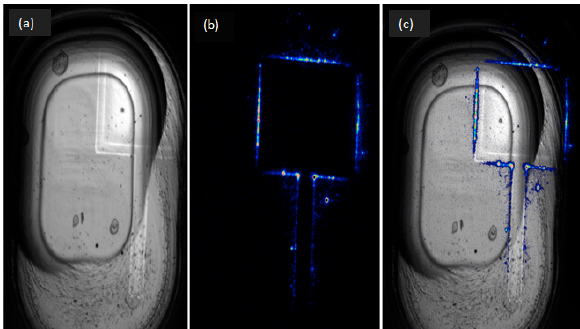
Fig. 2. (a) Pattern image of a backside opened Power MOSFET with the (x5) power lens. (b) Emission image. (c) Superimposed image.